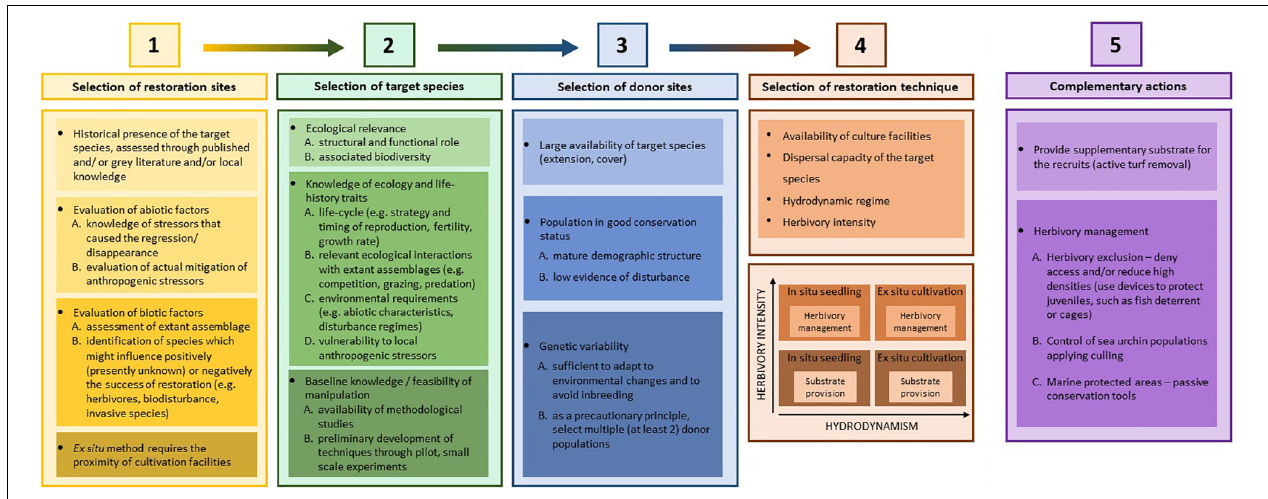
FIGURE 1 | Conceptual model of the crucial steps to guide the restoration of macroalgae forests. The knowledge and main factors and processes that must be considered for an optimal selection of restoration sites, target species, donor sites, restoration techniques, and the use of complementary actions are detailed and explained